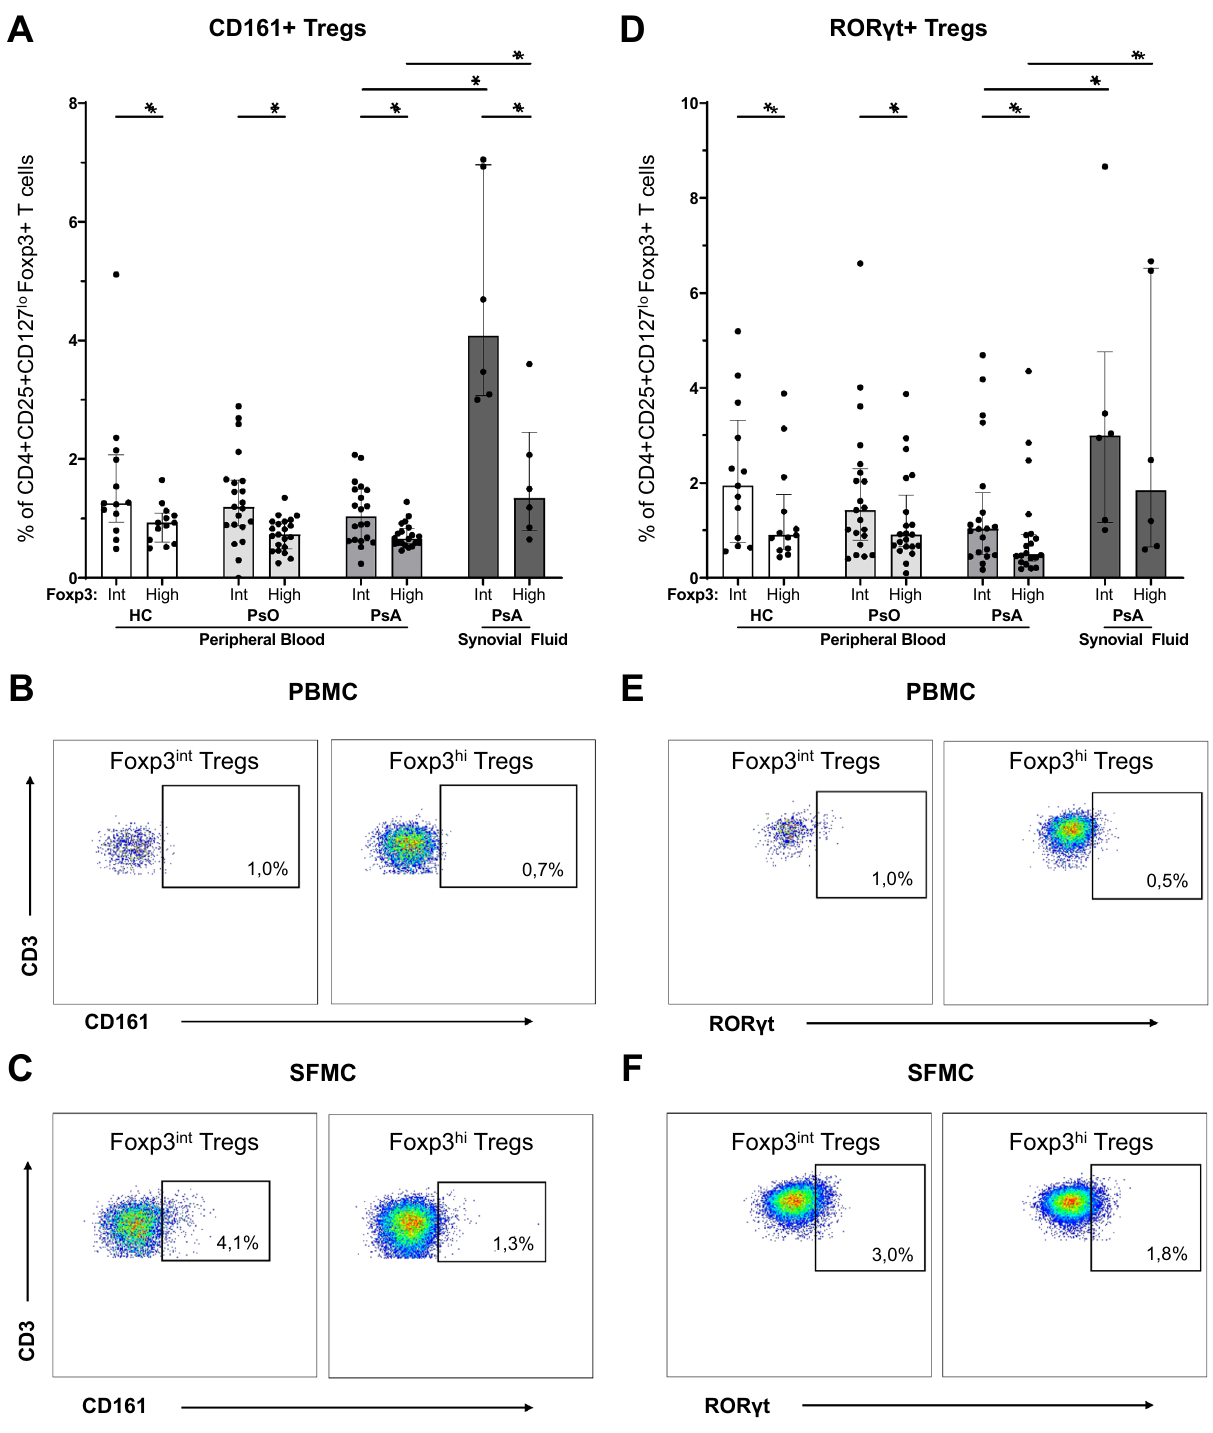
Figure 2. CD161 + RORγt + phenotype of synovial fluid-derived Foxp int and Foxp3 hi Tregs. Flow cytometry analysis of CD4 + CD25 + CD127 lo Foxp3 + Tregs derived from peripheral blood of HC (n = 13), psoriasis patients (n = 21) and PsA patients (n = 20), and from synovial fluid of PsA patients (n = 6). Bar graphs: symbols represent individual subjects; bars show median with interquartile range; * P value < 0.05 (synovial fluid only compared with PsA peripheral blood). Dot plots: percentages in PBMC plots represent median of PB-derived Tregs in PsA; percentages in SFMC plots represent median of SF-derived Tregs. ( A ) Proportions of CD161 + Foxp3 int and CD161 + Foxp3 hi Tregs. ( B-C ) Representative flow cytometry plots to identify CD161 + Foxp3 int and -Foxp3 hi Tregs derived from peripheral blood (B) and synovial fluid (C). ( D ) Proportions of RORγt + Foxp3 int and RORγt + Foxp3 hi Tregs. ( E–F ) Representative flow cytometry plots to identify RORγt + Foxp3 int and -Foxp3 hi Tregs derived from peripheral blood (E) and synovial fluid (F). Foxp3 int/-hi : forkhead box P3 expression intermediate/high; HC: healthy control; PBMC: peripheral blood mononuclear cells; PsA: psoriatic arthritis; PsO: psoriasis; RORγt: retinoic acid receptor-related orphan receptor gamma; SFMC: synovial fluid mononuclear cells; Tregs: T regulatory